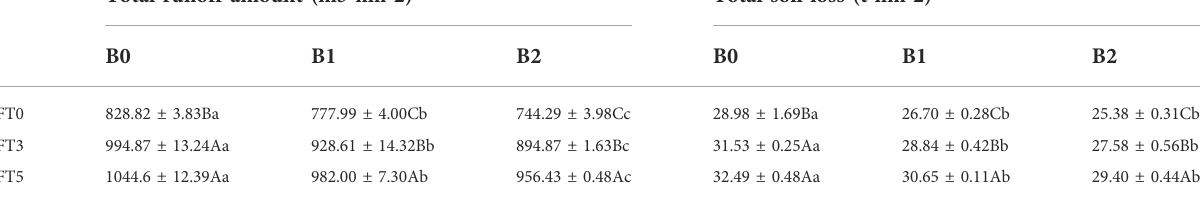
TABLE 2 Total runoff and soil loss in slope with different biochar application